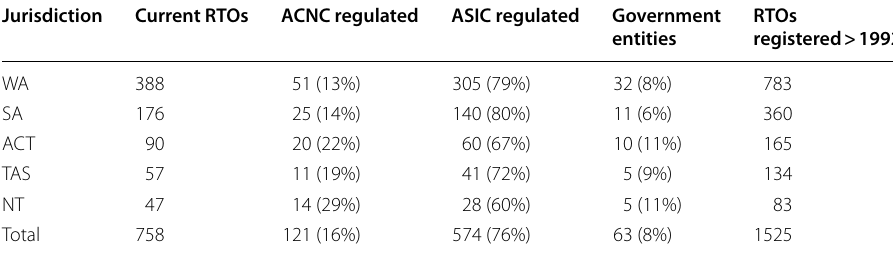
Table 1 RTO registration/regulation summary for each jurisdiction